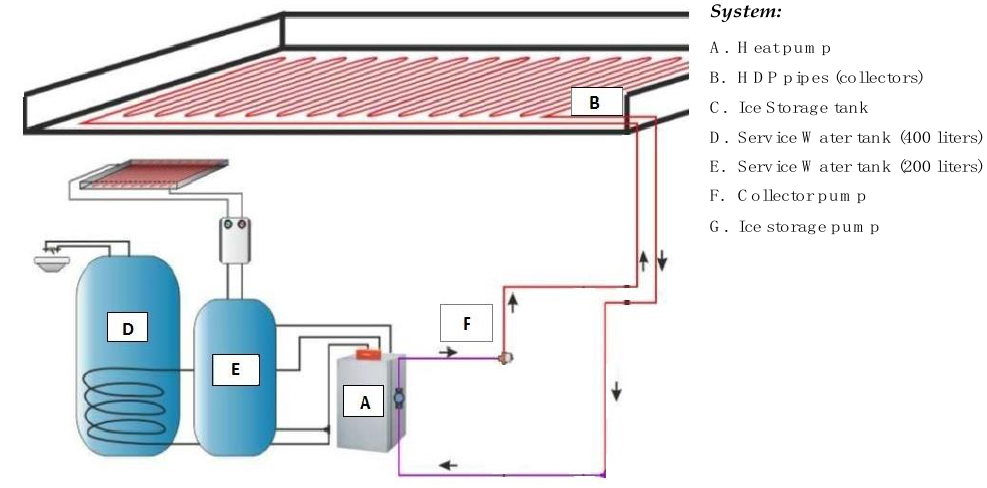
Figure 6. The first status of the heat pump.